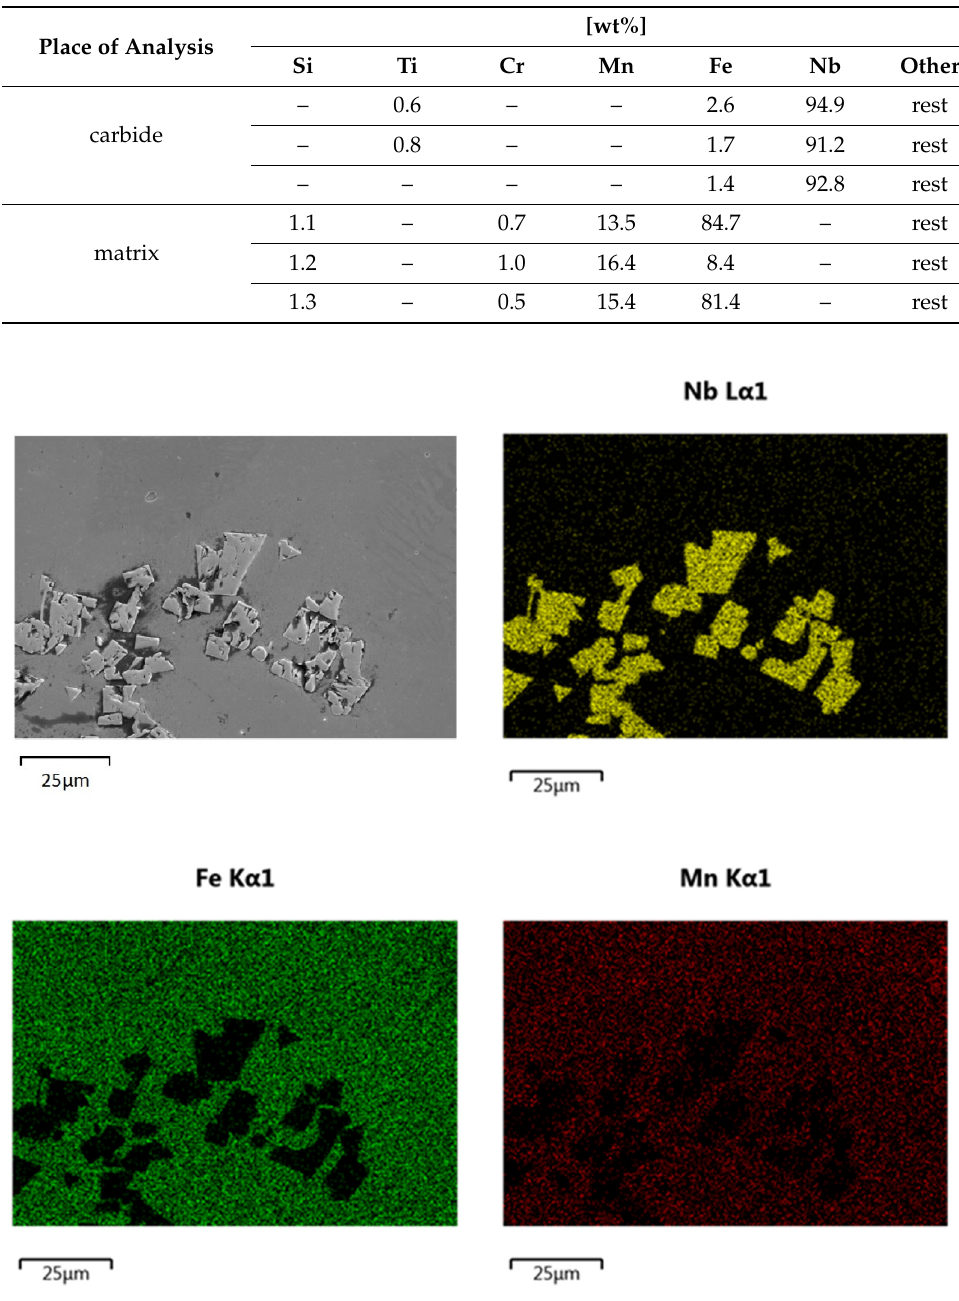
Figure 11. Surface distribution of Nb, Fe, and Mn in the area of niobium carbides.